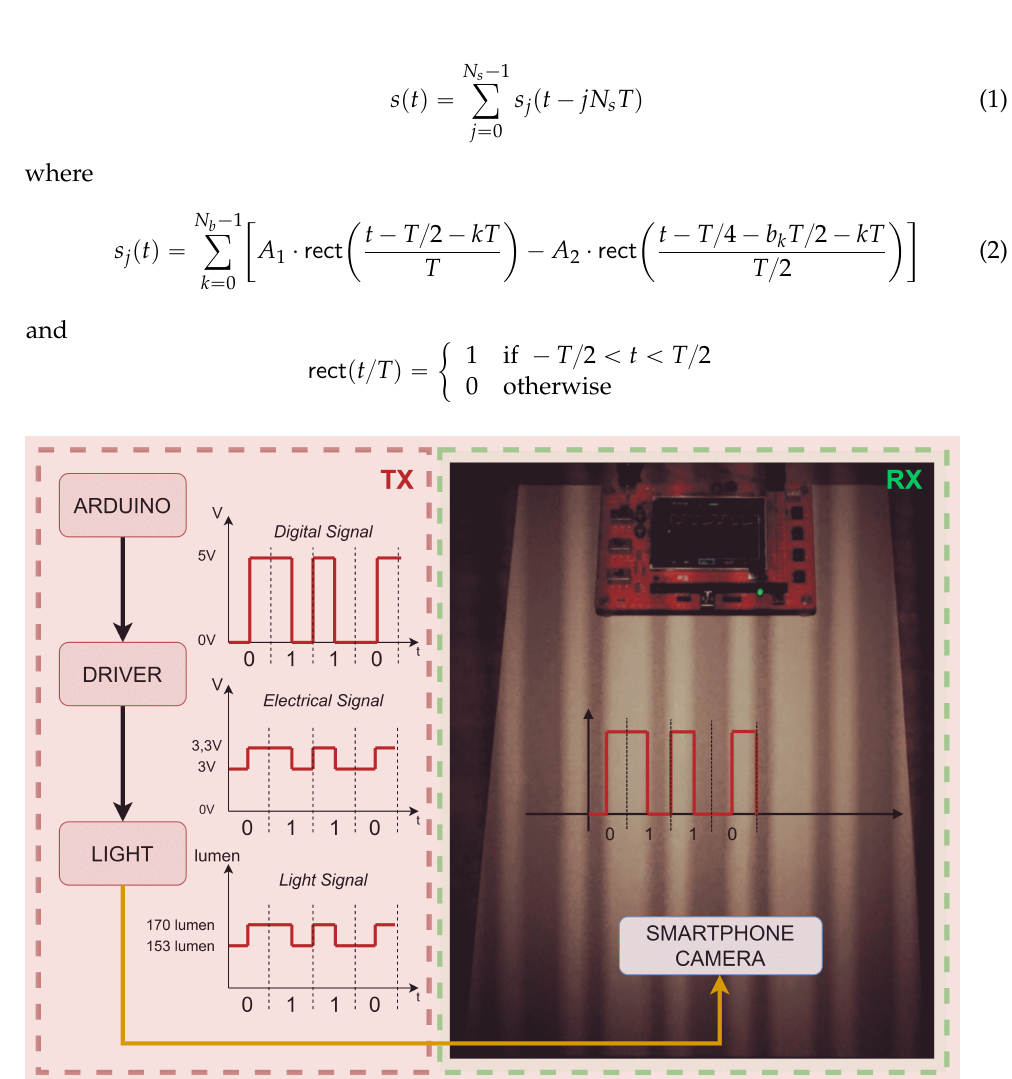
Figure 2. Block diagram of the transmission system used for the experiments. On the left, the block diagram of the transmitting chain; on the right, a photograph to demonstrate the data transmission into the